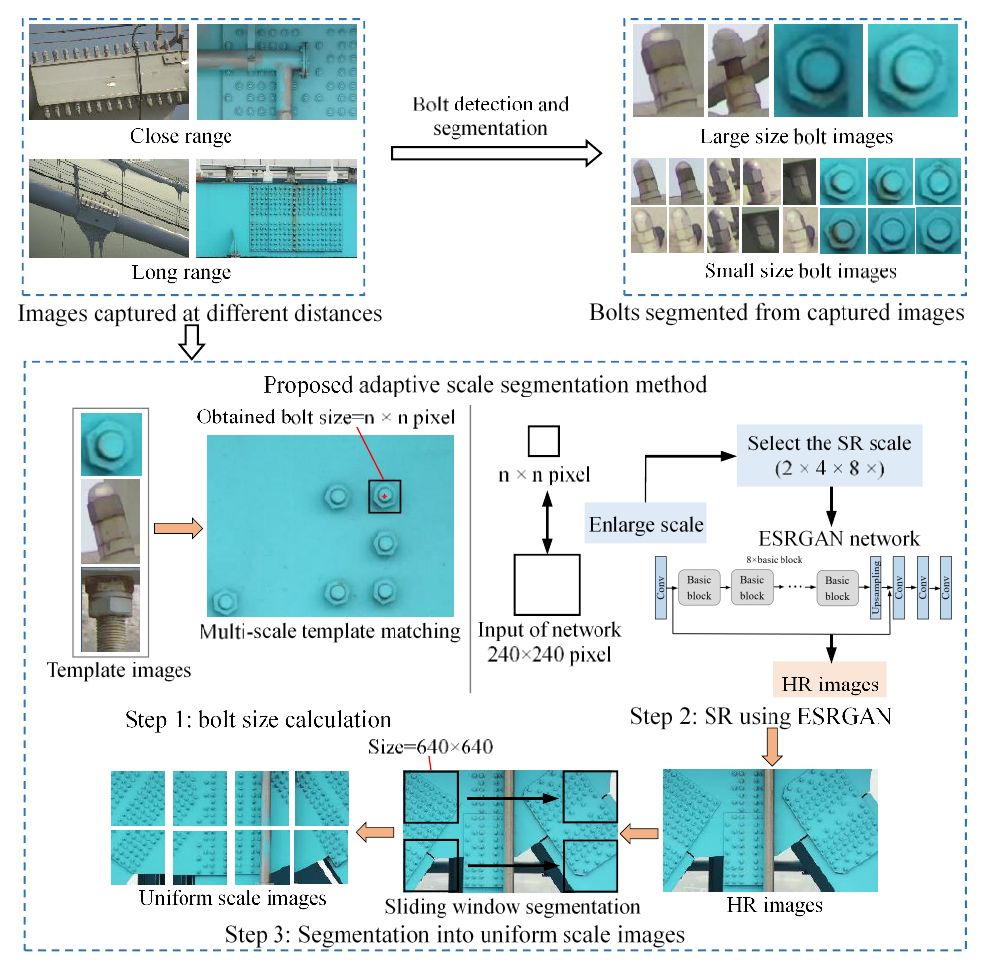
Figure 5. Workflow of adaptive scale segmentation method.